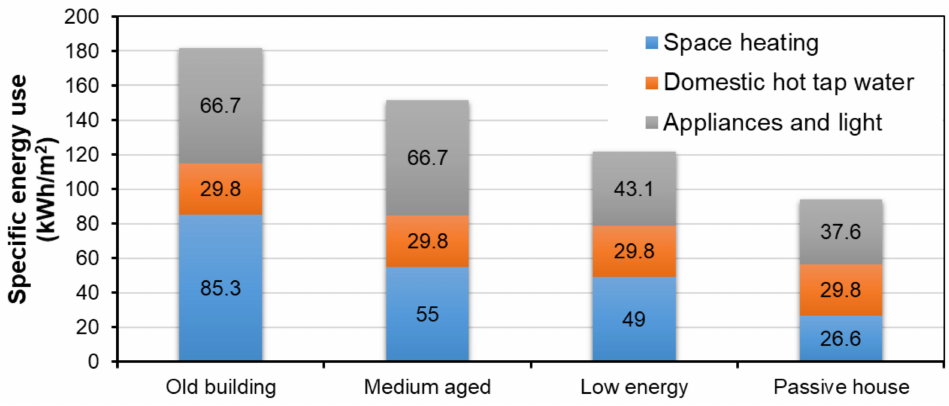
Figure 4. Energy use composition of single